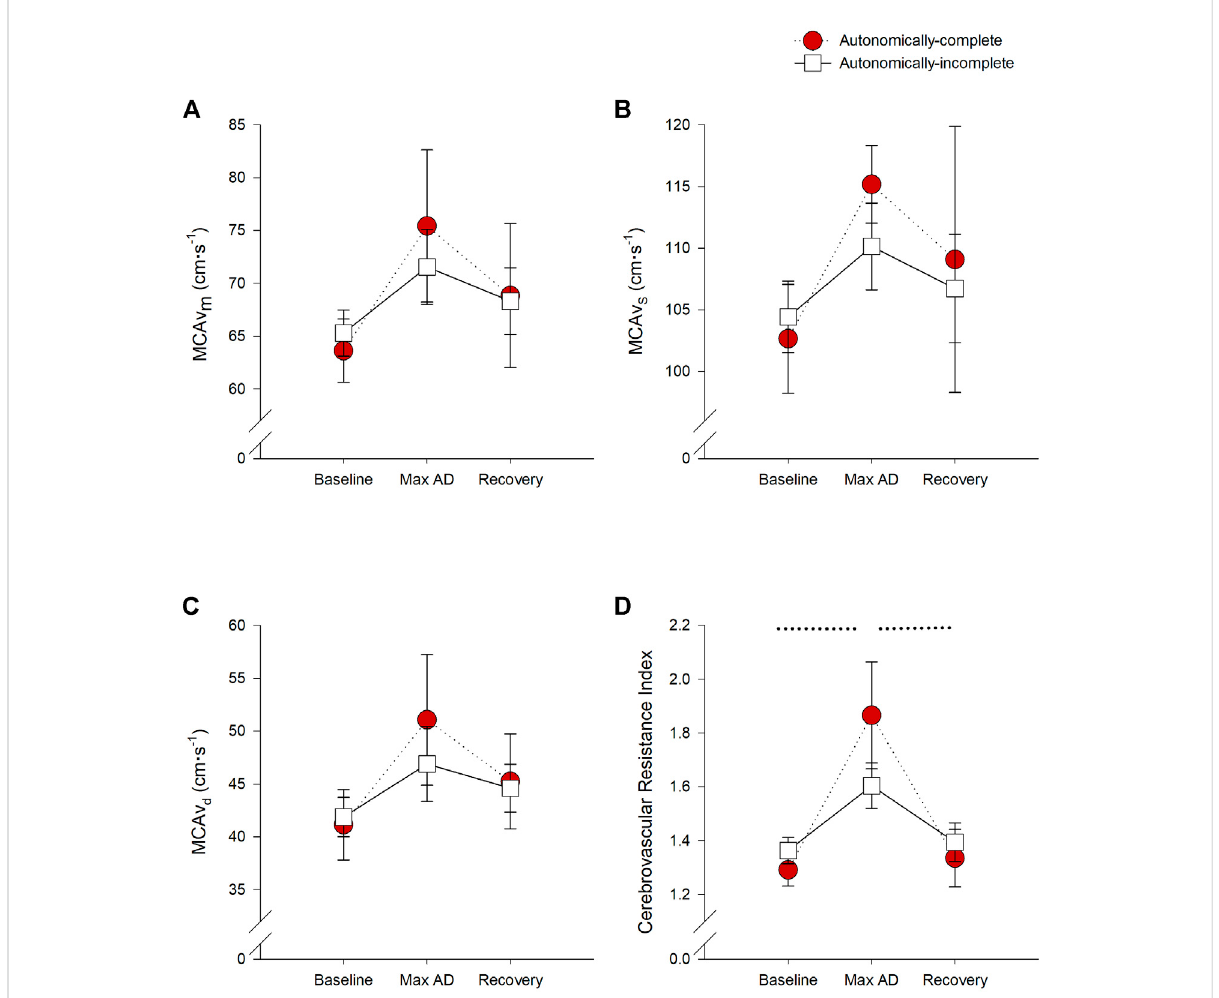
FIGURE 4 Impact of autonomic severity of injury on cerebrovascular responses during urodynamics testing. Neither mean (A) , systolic (B) , or diastolic (C) cerebral blood fl ow velocities were signi fi cantly different within or between groups. However, when assessing cerebrovascular resistance (D) , resistance was signi fi cantly increased during UDS compared to baseline ( p = 0.001) and recovery ( p = 0.003) in those with autonomically-complete injuries. Additionally, cerebrovascular resistance tended to increase in those with autonomically-complete injuries compared to those with autonomically-incomplete injuries ( p = 0.065) during UDS. Statistical signi fi cance: * denotes statistical difference between groups; dashed line (---) denoteschangesovertimeinautonomically-completegroup.Abbreviations:AD,autonomicdysre fl exia;MCAv m